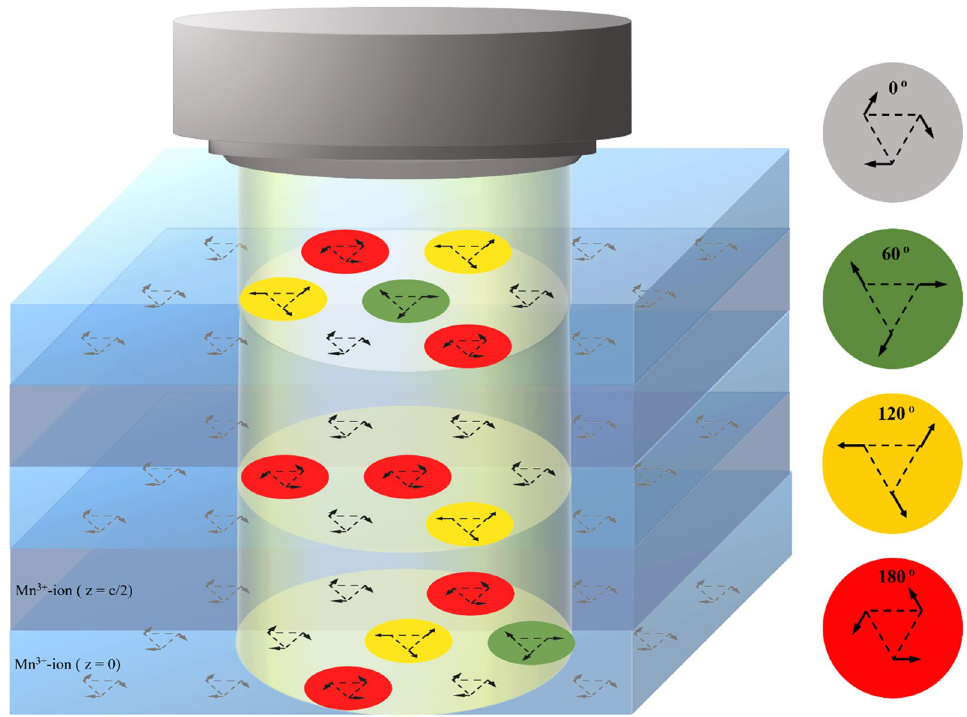
Figure 4. A visualization of the isolated spin-rotational excitations. Below T N , the Mn 3+ -ions are lying on each xy plane maintaining the Ŵ 4 spin structure. The spin states are excited by simultaneous rotation of the three spins in a trimer by 60° (green bubbles), 120° (orange bubbles), and by 180° (red bubbles) under the resonant light. The symmetry of the triangular lattice allows only these three rotations in hexagonal LuMnO 3